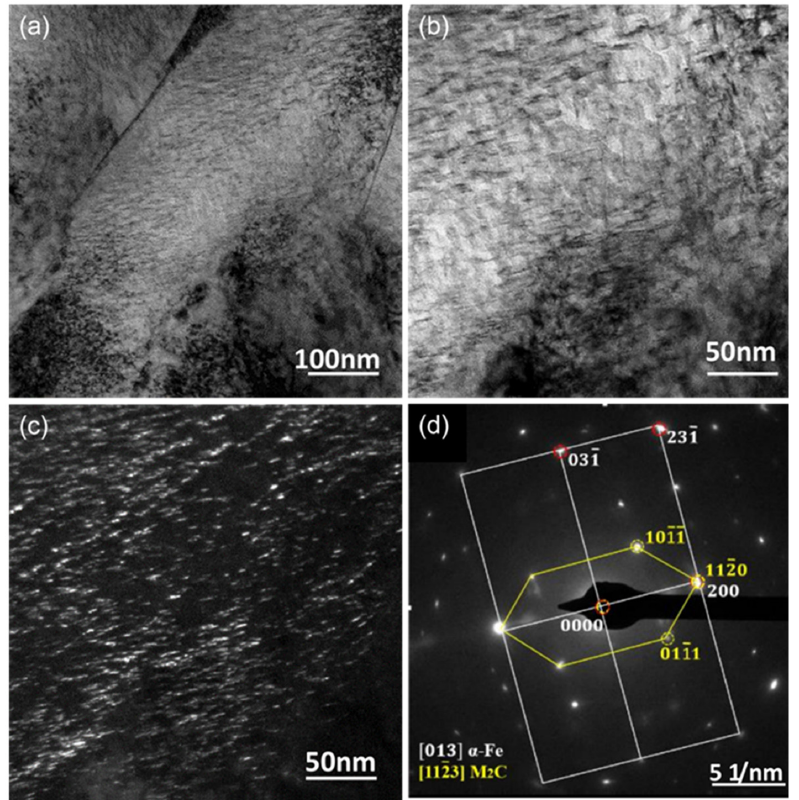
Figure 9. TEM characterization of the C-0.65 HSS coatings after triple-tempering at 530 °C: ( a , b ) brightfield images; ( c ) dark field image; ( d ) the corresponding SAED pattern for ( b ) [56].